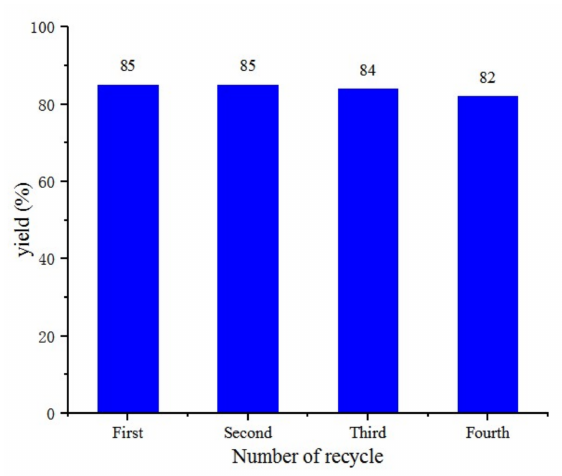
Figure 4. Recyclability of the